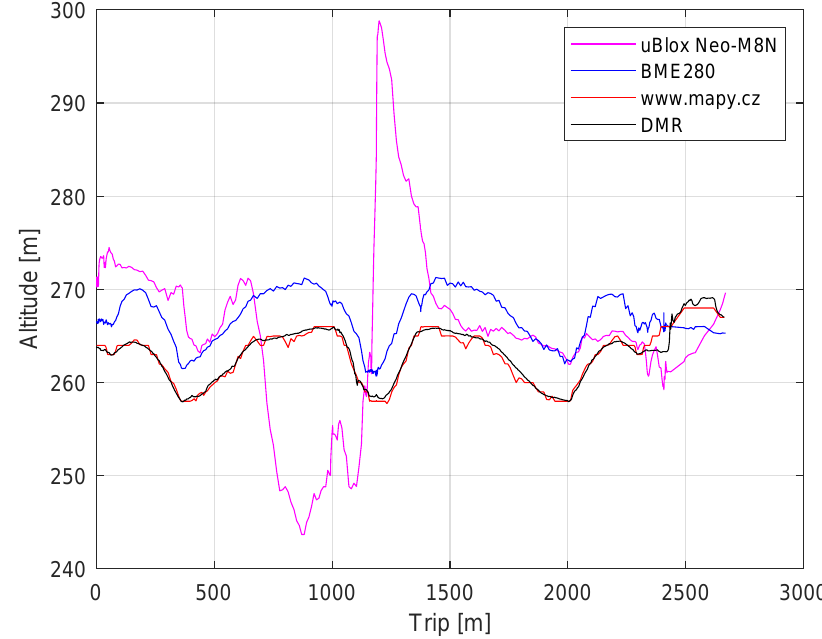
Figure 9. Comparison of route altitude